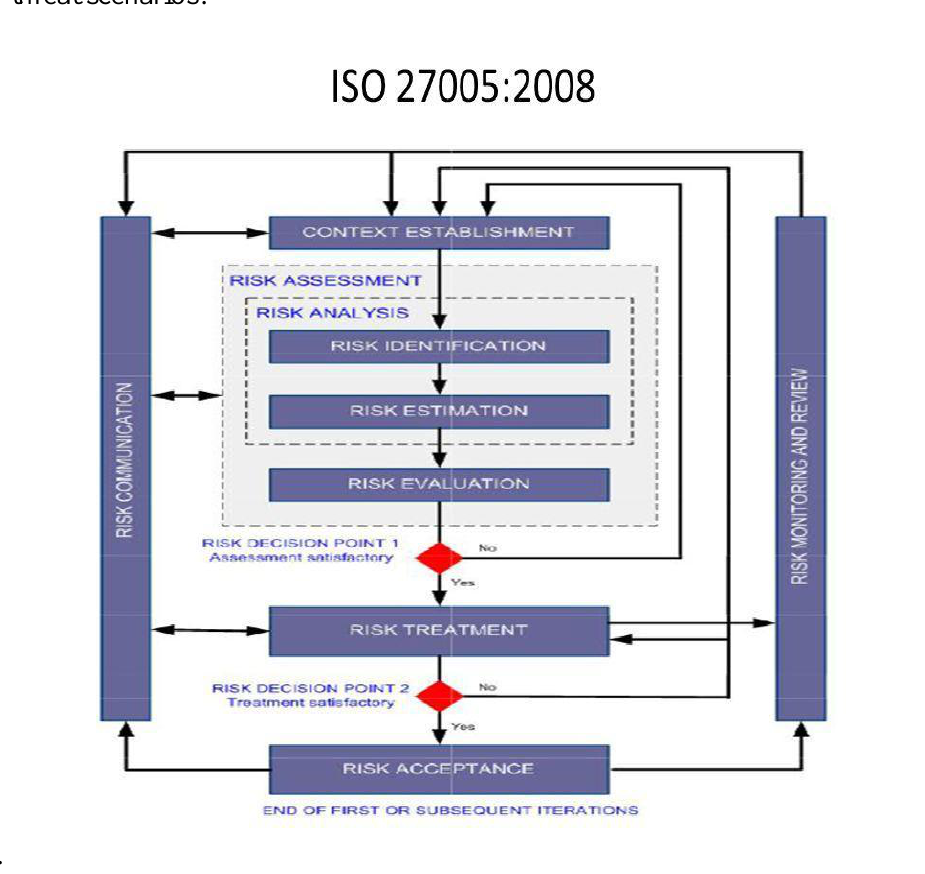
Figure 1. Risk Analysis Flowchart – based on